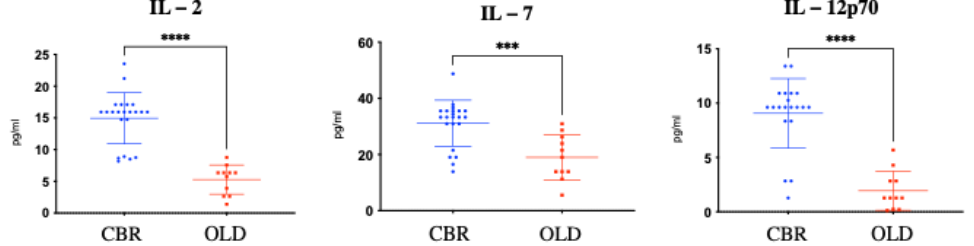
Figure 1. Graphs representing the plasma levels of the molecules found over-expressed in CBR individuals (blue dots) with respect to age-matched OLD control individuals (red squares) as measured by Bio-Plex methodologies. The non-parametric Mann – Whitney test was used for statistical comparison between the two examined groups. p -values for each statistically significant comparison have been reported (* p < 0.05; ** p < 0.01; *** p < 0.001; **** p < 0.0001).